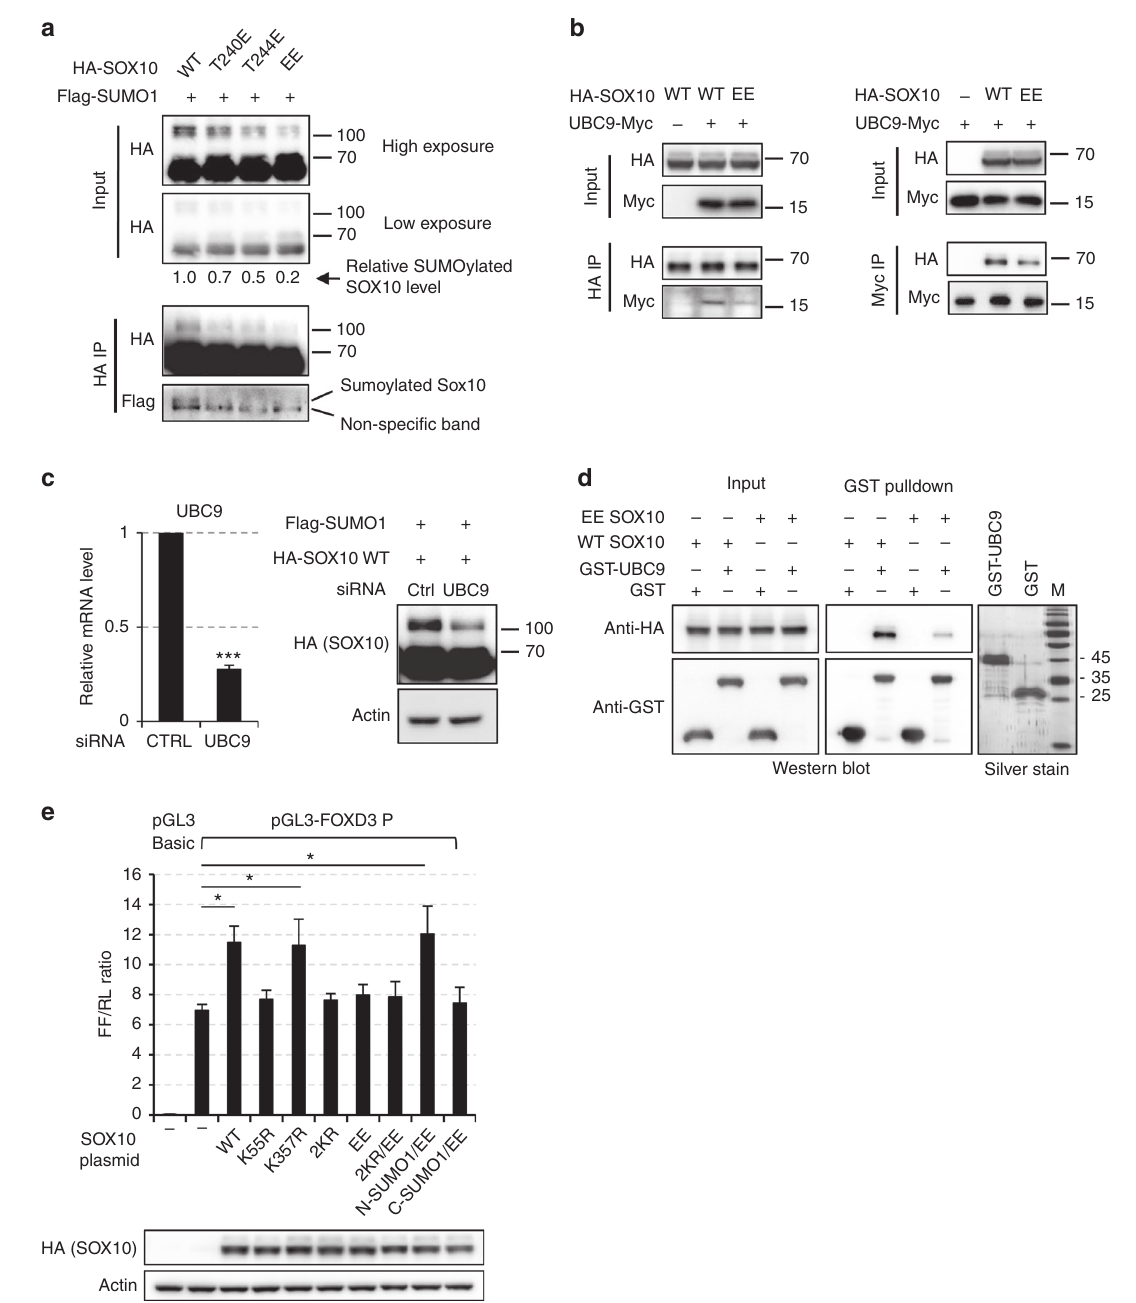
Fig. 6 Phosphorylation at T240 and/or T244 inhibits SOX10 sumoylation. a HEK293T cells were co-transfected with plasmids expressing Flag-SUMO1 and one of the HA-SOX10 variants including WT, T240E, T244E, and EE. After 48 h, immunoprecipitation was performed with HA-tag antibody. Inputs and immunoprecipitates were analyzed by western blot. Relative levels of SOX10 sumoylation were quantitated by normalizing the intensities of the sumoylated bands against the non-sumoylated bands. b HEK293T cells were transfected with HA-SOX10 and UBC9-Myc expressing plasmids for 48 h. Reciprocal immunoprecipitations were performed using anti-Myc (left) or anti-HA (right) antibodies. Inputs and immunoprecipitates were analyzed by western blots. c HEK293T cells were co-transfected with WT HA-SOX10 and Flag-SUMO1 plasmids, ± UBC9 siRNAs for 48 h. Cells were then lysed for qPCR (left) and western blot (right) analysis. Average qPCR results from three independent experiments is shown and error bars represent standard deviation. Signi fi cance was determined by Student's two-tailed t- test, *** p < 0.001. d GST pull-down experiments were performed using recombinant GST- UBC9 or GST and sonicated lysates of 293T cells expressing WT or EE HA-SOX10. Input and pull-down proteins were analyzed by western blot. e HEK293T cells were co-transfected with 500 ng of pGL3-FOXD3, 50 ng of pRL-TK and 500 ng of indicated SOX10 plasmids. After 48 h, cells were lysed and dual-luc fi ferase assays were performed. Average ratios of fi re fl y and renilla luciferase activities (FF/RL) from three experiments are shown. The expressions of exogenous HA-SOX10 variants were veri fi ed by western blot. Error bars represent standard deviation. Signi fi cance was determined by ANOVA one-way test, * p < 0.05. Uncropped images are shown in Supplementary Fig.